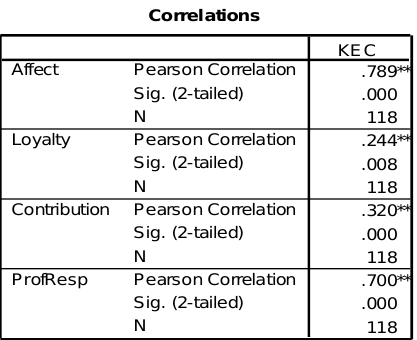
Table 4: Correlation between KEC and